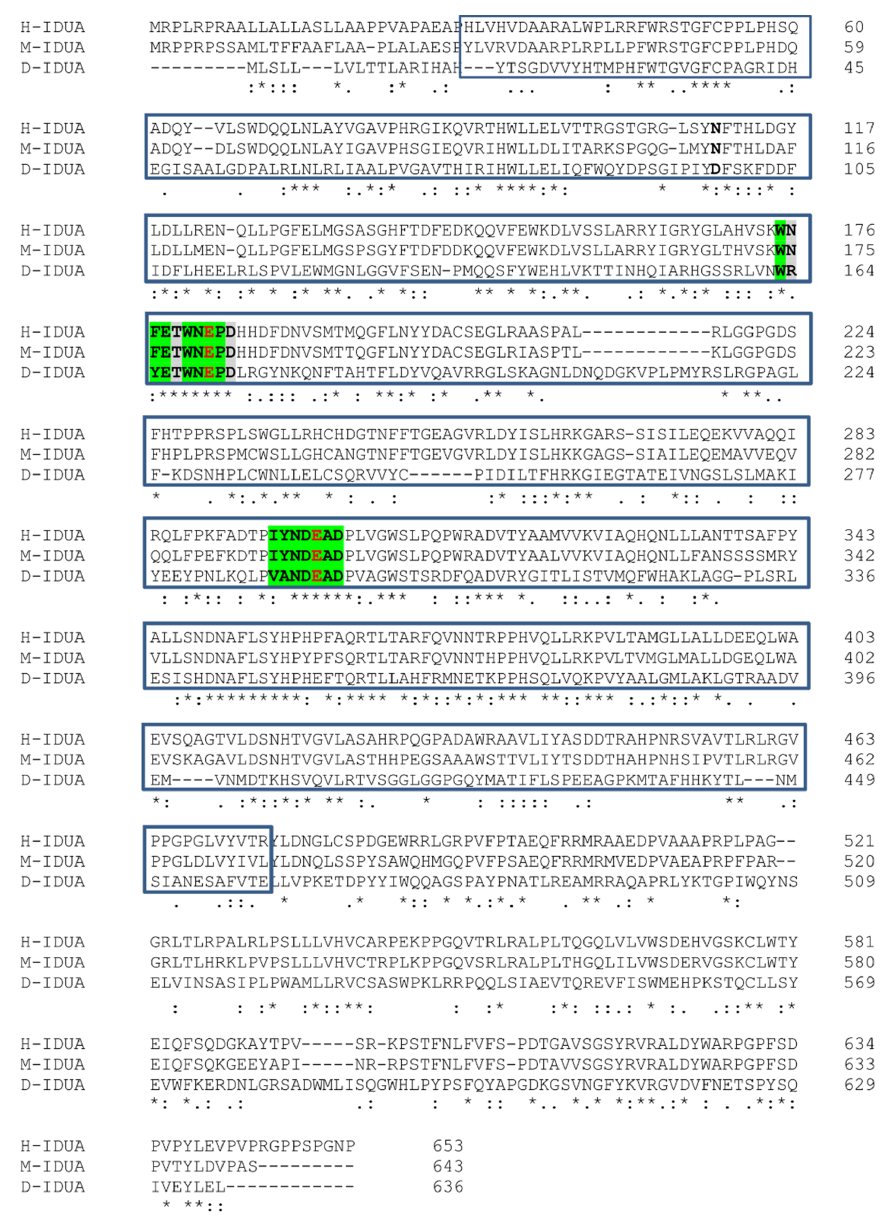
Figure 1. Human, mouse, and Drosophila IDUA protein alignment. Sequence alignments of human, mouse, and Drosophila IDUA proteins. The glycosyl hydrolase domain is boxed in blue, highlighted in green are the regions flanking the predicted nucleophiles and acid/base catalysts, and the acid/base residue and nucleophile are marked in red. * (asterisk) indicates positions which have a single, fully conserved residue. (colon) indicates conservation between groups of strongly similar properties. (period) indicates conservation between groups of weakly similar properties. As the CG6201 coding protein was structurally conserved, we tested whether CG6201 has the functional capability to catalyze the human substrate 4MU-iduronide. For this purpose, wild-type larvae at third instar stage and adult flies were evaluated for